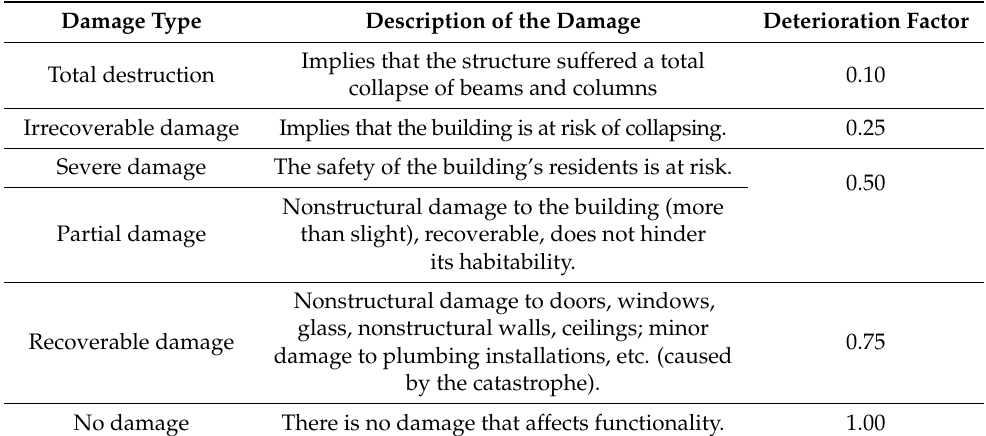
Table 2. Damage type and deterioration